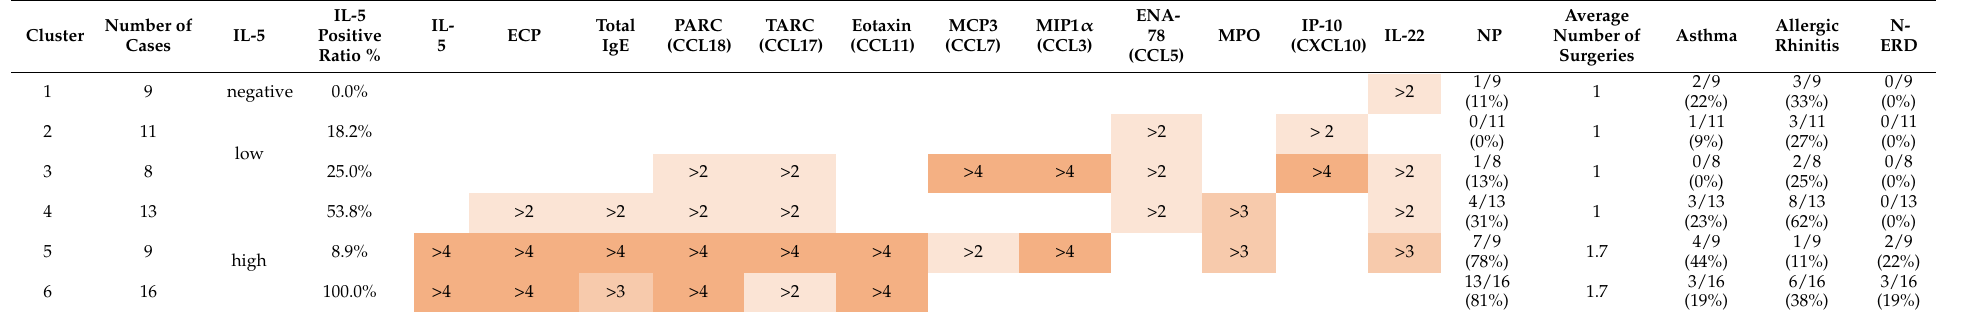
Table 5. Association of the endotypes with the clinical phenotypes. Simplified schema of the clusters and their characteristic chemokines and the proportion